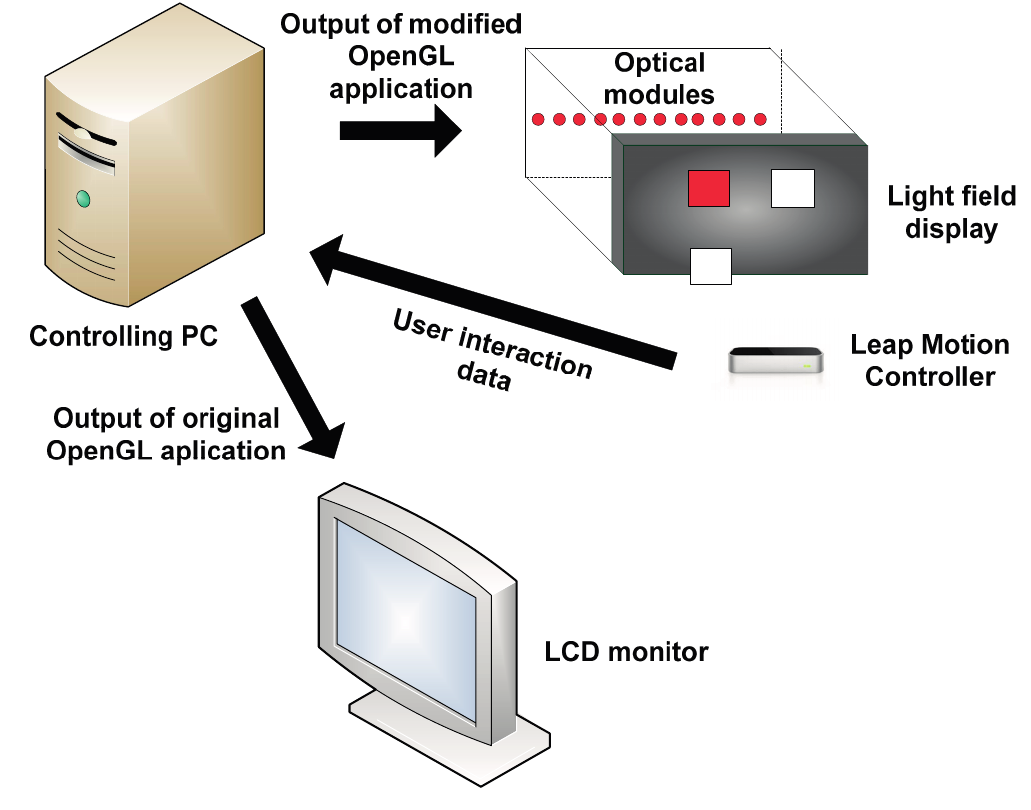
Figure 7. Experimental setup: The controlling PC runs two applications: main OpenGL frontend rendering application for 2D LCD display and backend wrapper application that tracks the commands in current instance of OpenGL (front end application) and generates modified stream for light field rendering. The front end rendering application also receives and processes user interaction commands from Leap Motion Controller in